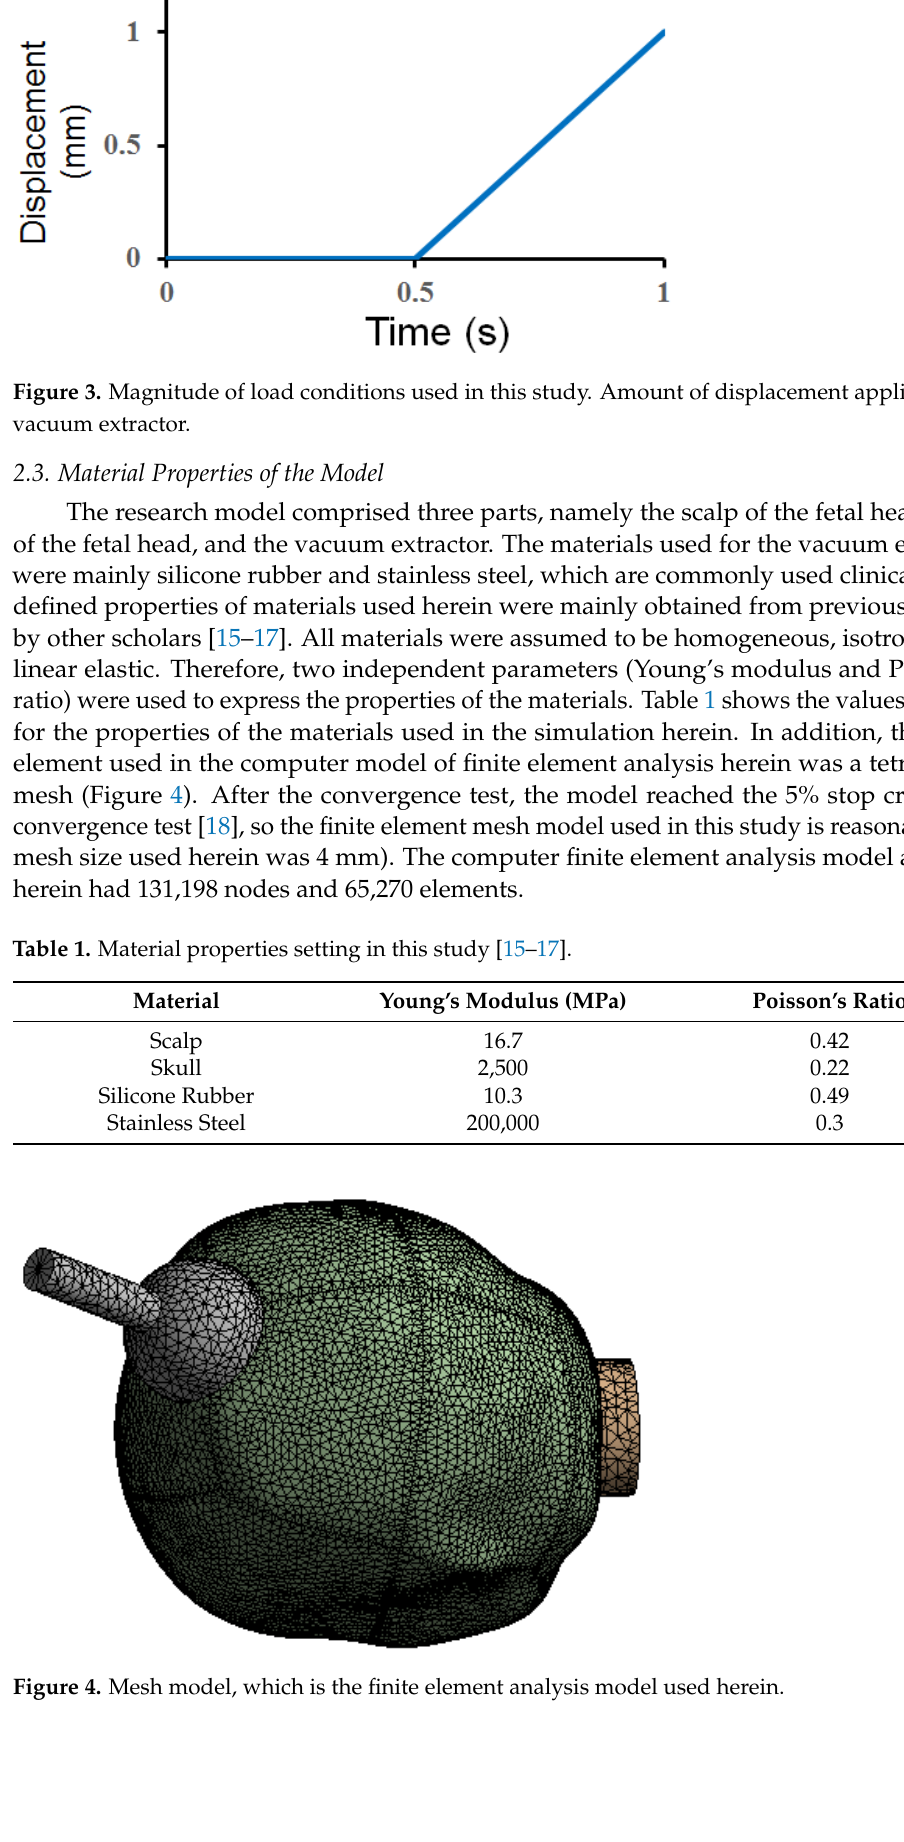
Figure 2. Magnitude of load conditions used in this study. Vacuum pressure applied to the crown area of fetal head.